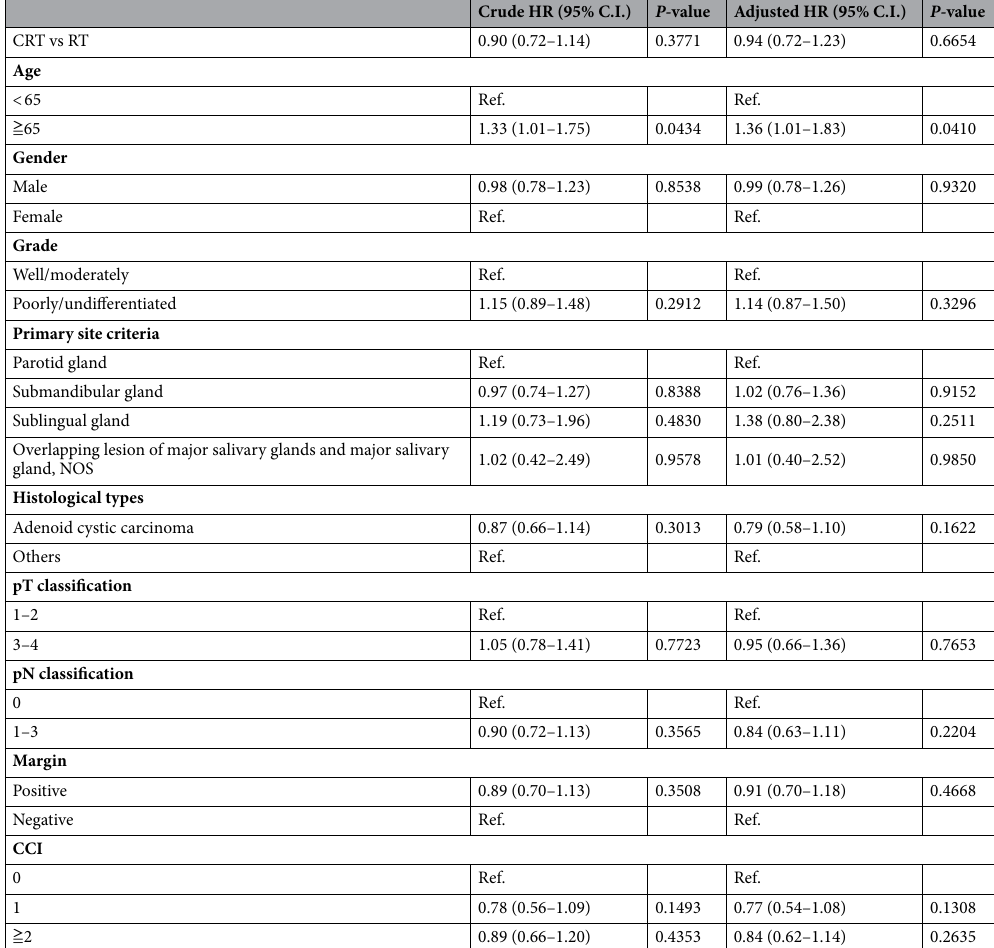
Table 2. Risk factor of overall survival in advanced major salivary gland cancer patients, n = 395. RT radiotherapy, CRT chemoradiotherapy, CCI Charlson Comorbidity